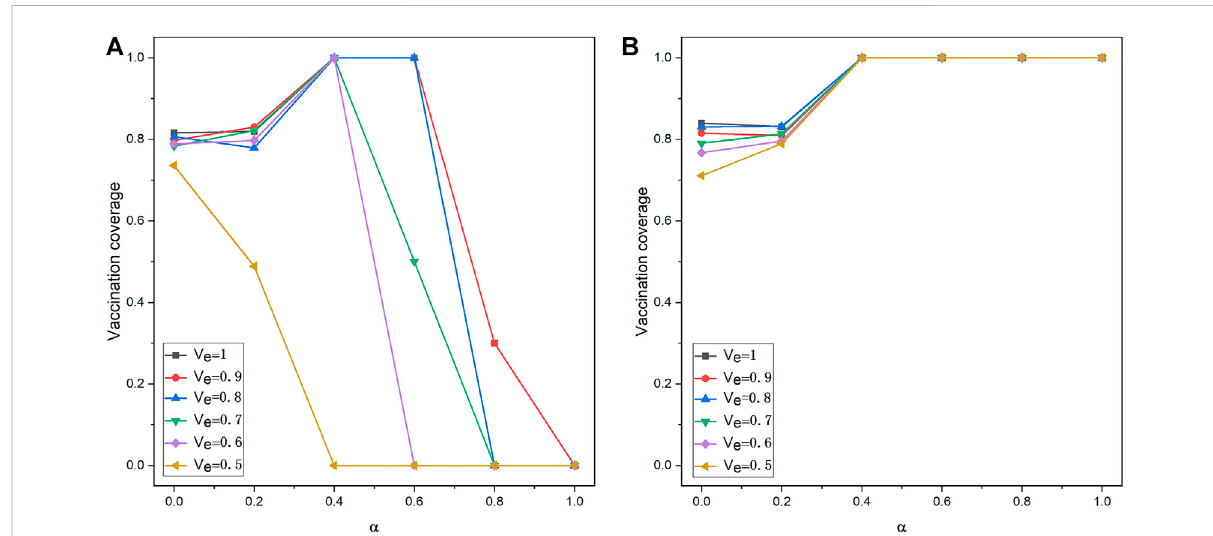
FIGURE 8 Vaccination coverageasafunctionofthestrengthofstrategy conformityeffect α for V 0 =0.2 (A) and V 0 =0.6 (B) .Depictedresultsareobtained for γ = 0.8, K = 0.1, C V = 0.3, and C H = 1.